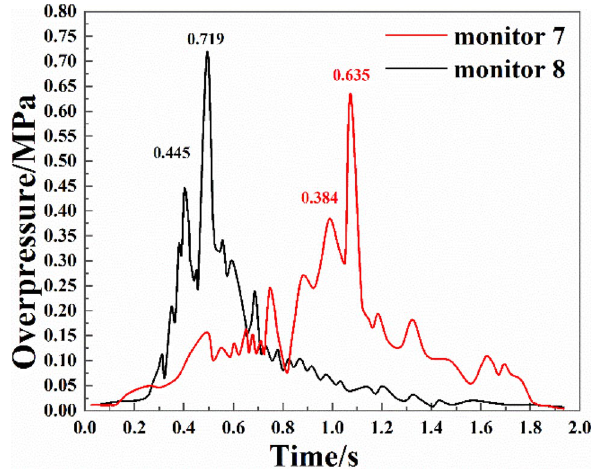
Figure 7. Overpressure change of bifurcation